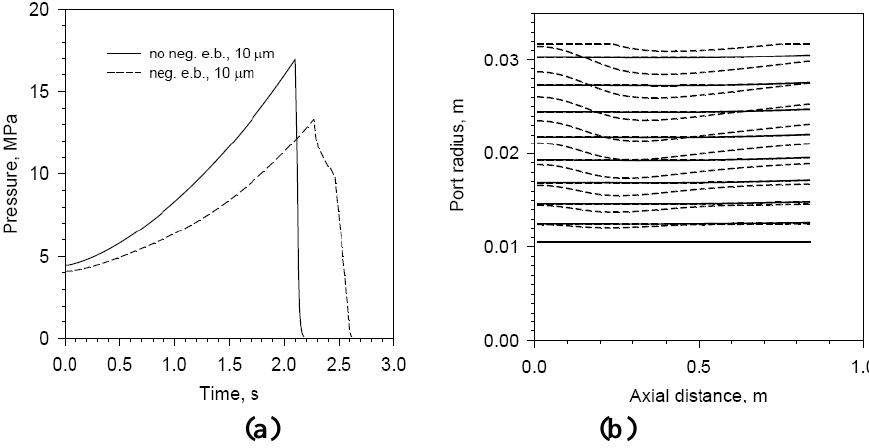
Figure 5. (a) Predicted head-end pressure profile for reference cylindrical-grain SRM, with and without a negative erosive burning model component, at a low propellant surface roughness of 10 : m; (b) Predicted port grain radius profile, with (dashed curves) and without a negative erosive burning model component (solid curves), at 0.25-sec increments.